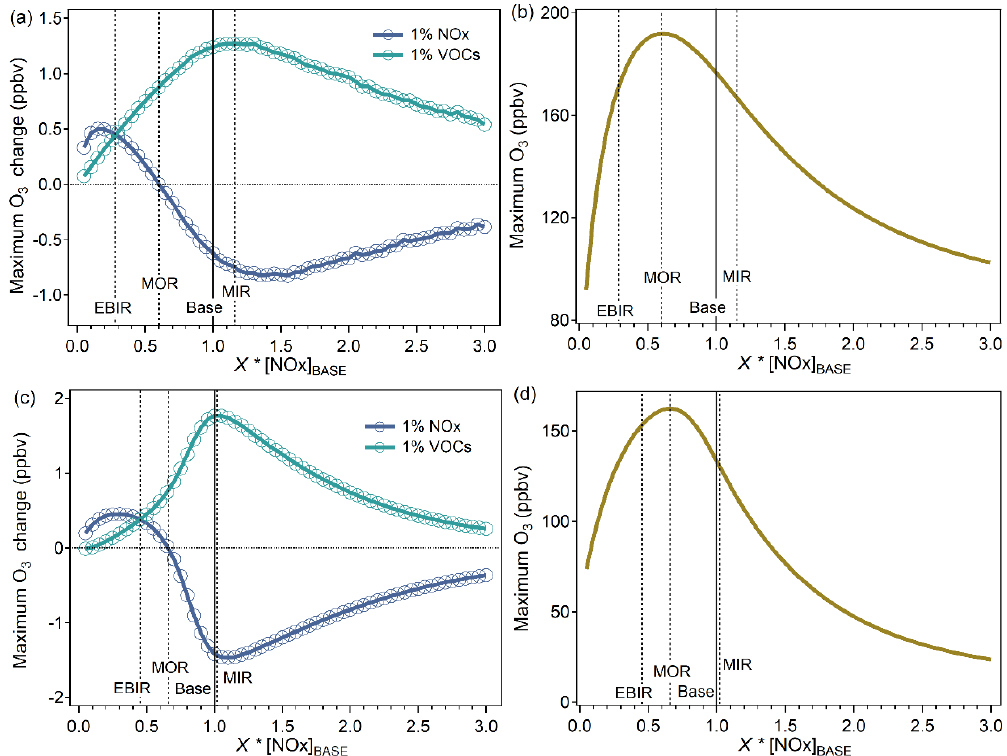
Figure 2. Identification of the MIR, MOR, and EBIR scenarios. The model-simulated (a, c) maximum hourly O 3 change caused by 1% increases in VOC or NO x inputs and (b, d) maximum hourly O 3 as a function of X × base case NO x inputs (represented as [ NO x ] BASE ). The upper panel shows the observation-based inputs and the lower panel shows the emission-based inputs. The MIR scenarios represent the NO x conditions in which VOC control has the greatest effect on O 3 formation. The MOR scenarios represent the NO x conditions that are optimal for O 3 formation. The EBIR scenarios represent NO x conditions in which O 3 formation transits from a mixed-limited regime to an NO x -limited